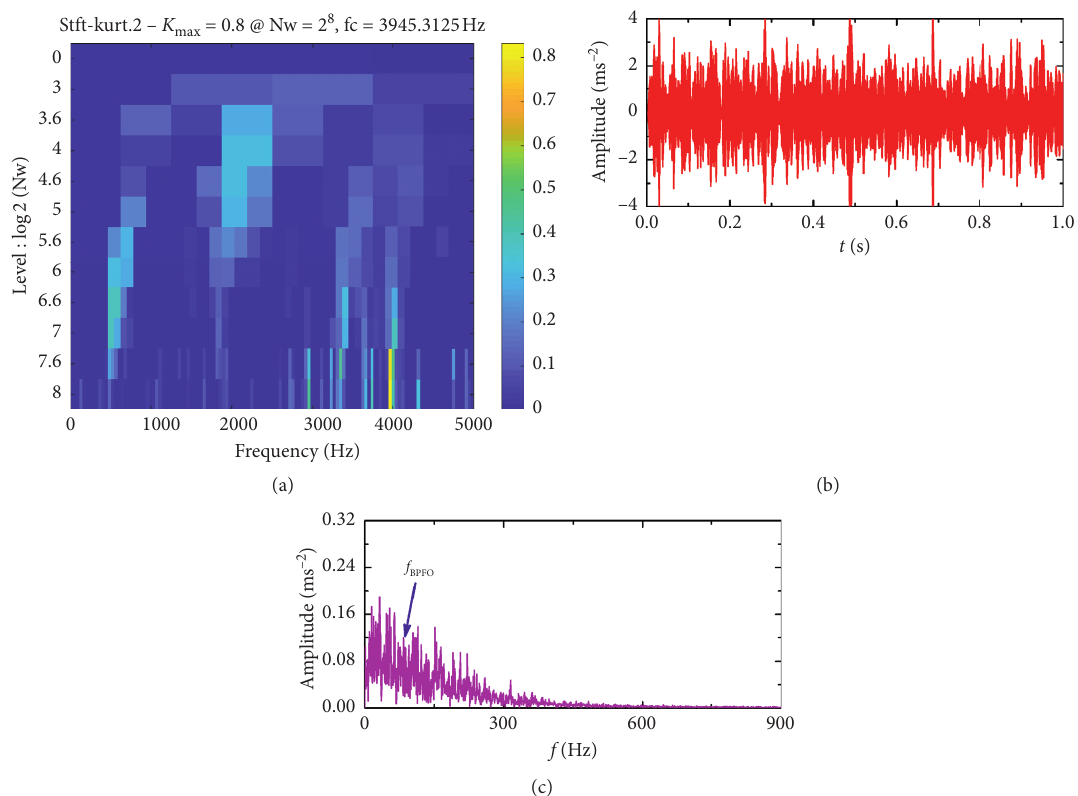
Figure 17: Results obtained by fast kurtogram: (a) kurtogram, (b) extracted signal, and (c) Hilbert envelope spectrum of signal in (b).